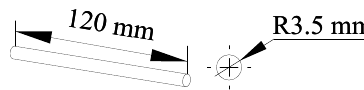
Figure 7. Drawing of the upper board structure.